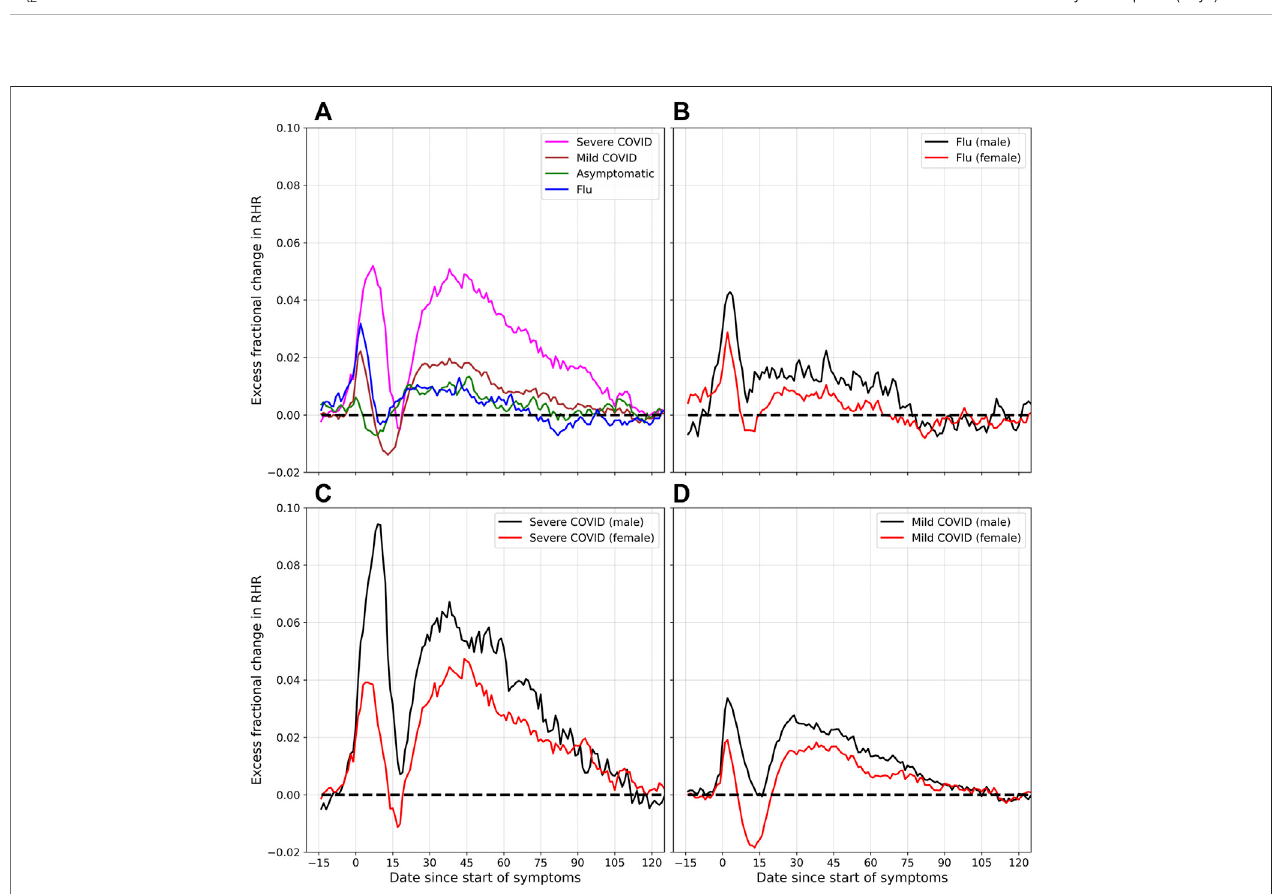
FIGURE4| ExcessfractionalchangeinRHR( Δ ξ ),andvariationwithseverityandsex: (A) shows Δ ξ forsevere,mild,andasymptomaticCOVID-19,aswellas fl u. (B) shows Δ ξ for male and female individuals diagnosed with fl u. (C) and (D) show Δ ξ for male and female participants, for the cases for severe and mild COVID-19 respectively.